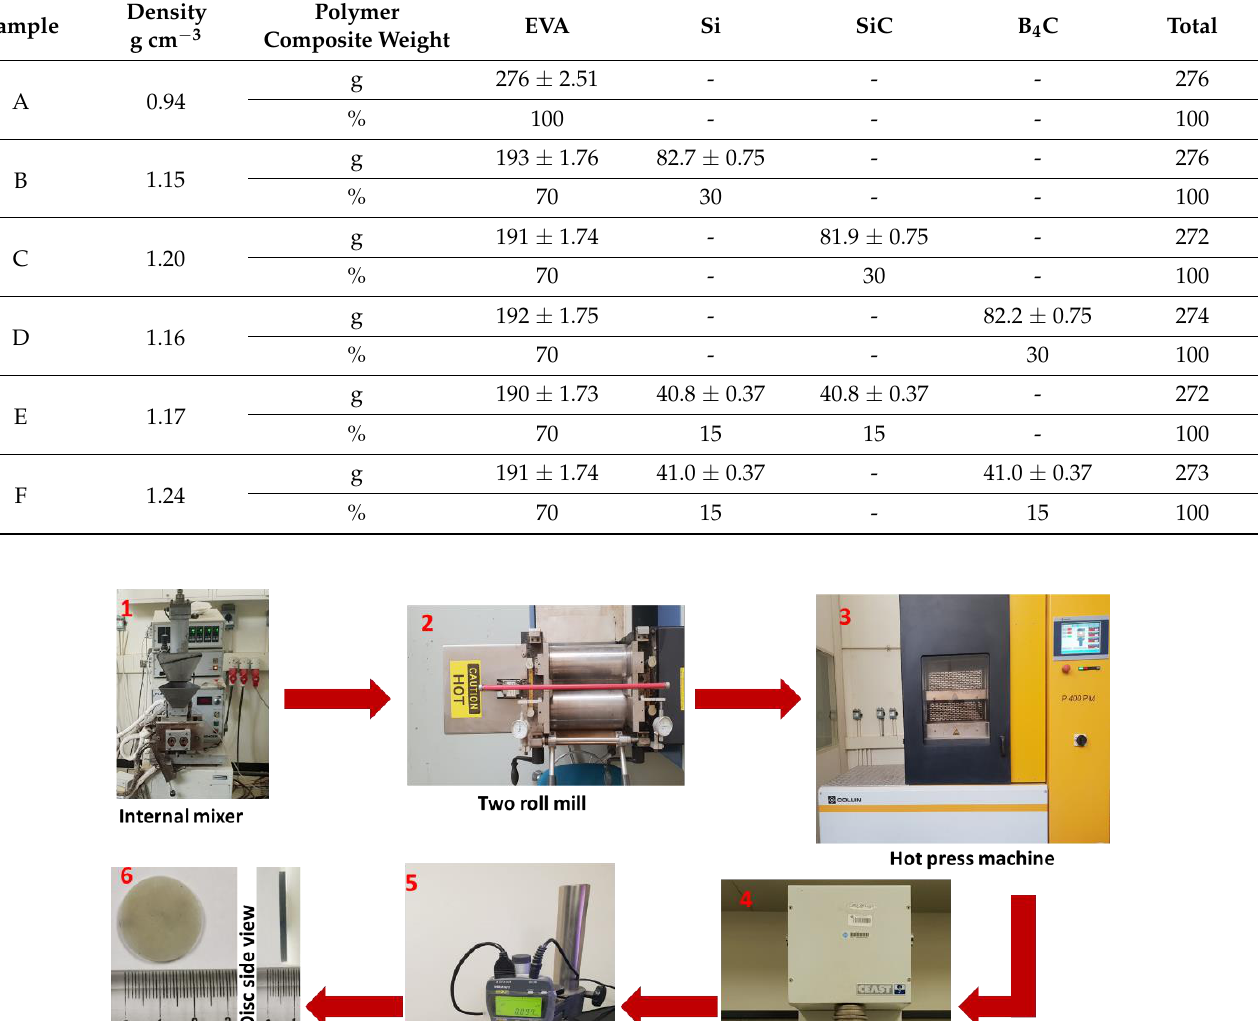
Table 1. Composite sample list with component masses in g ± σ .